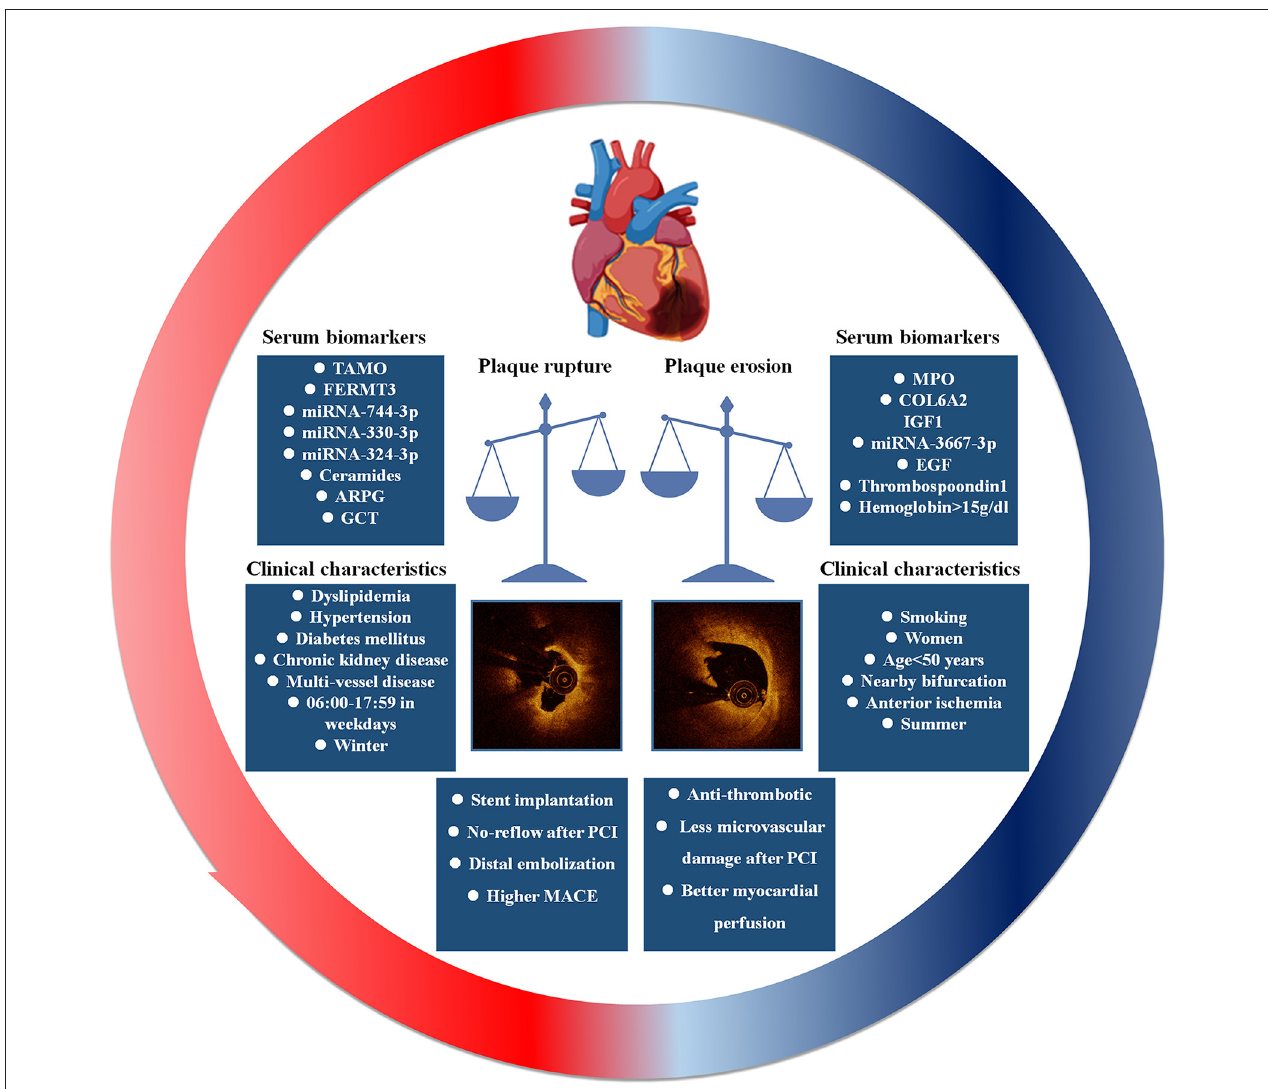
FIGURE 3 | The prediction and clinical outcome of plaque erosion and plaque